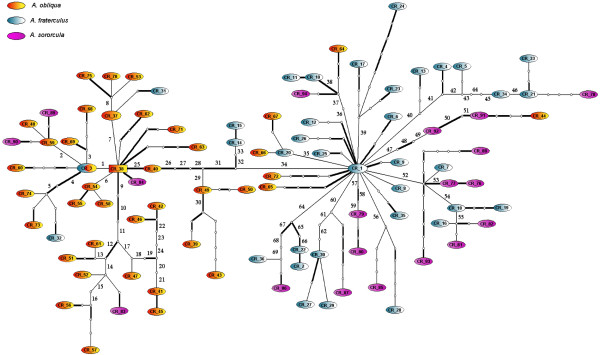
Haplotype network of fru C3 exon. Empty circles indicate missing intermediate haplotypes (extinct or unrepresented in the sample). Each line indicates a mutation step which separates different haplotypes. The area of the circles representing each haplotype is proportional to the number of individuals carrying the haplotype.